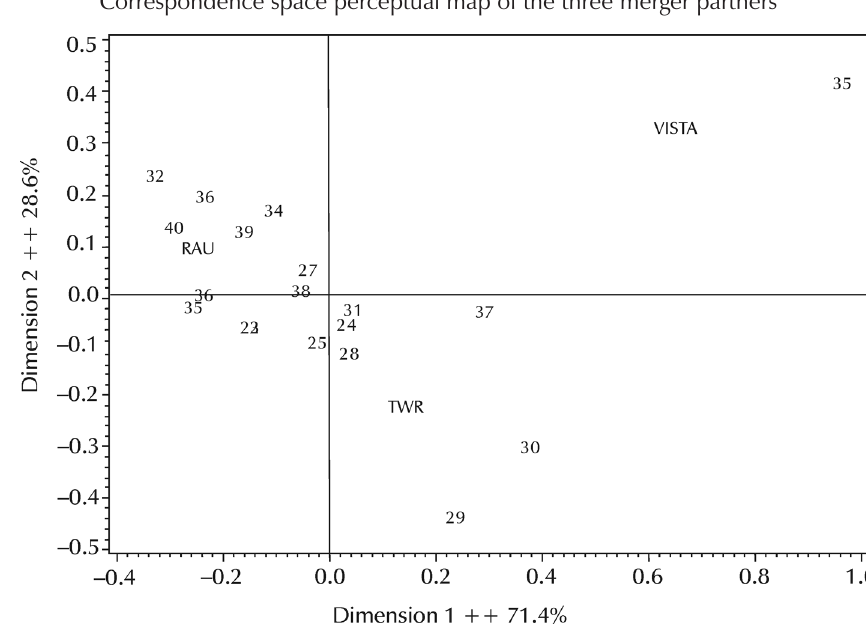
Correspondence space perceptual map of the three merger